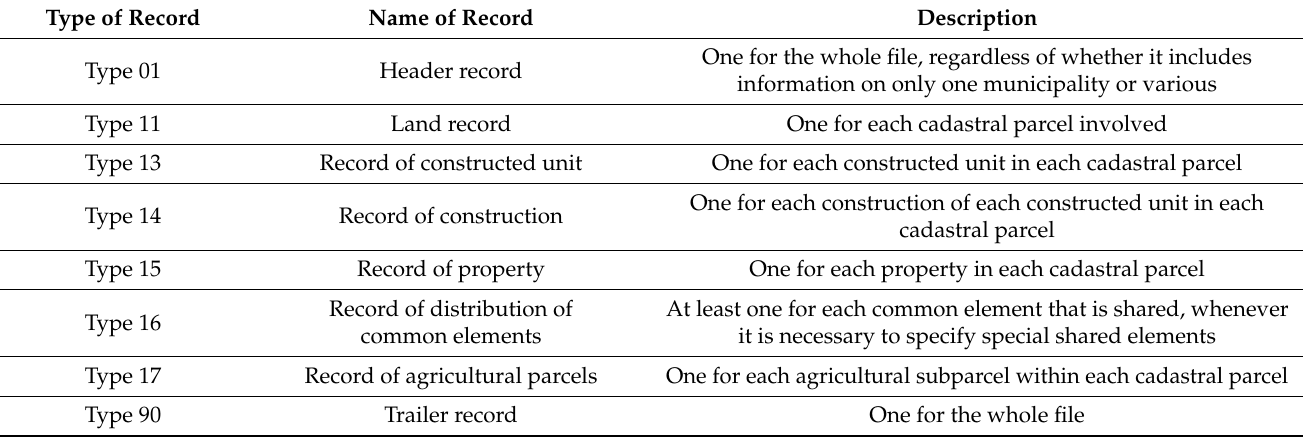
Table 1. Structure of CAT files 1 .